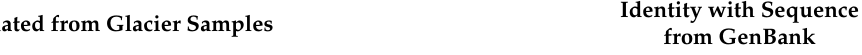
Table 1. Fungi cultured from cryoconite holes in the Werenskiold Glacier (Spitsbergen) on different media and at incubation temperatures. The BLAST analysis was performed on 25 April 2021 (all values of query cover were 100%; all E values were